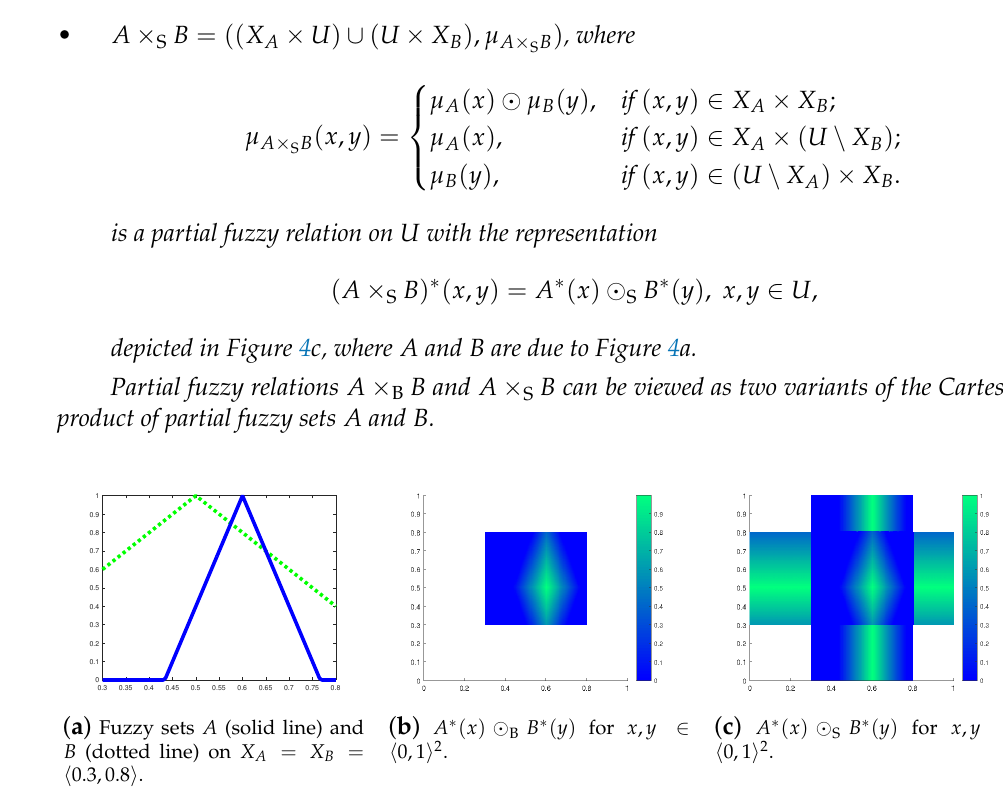
Figure 4. Examples of partial fuzzy relations from Example